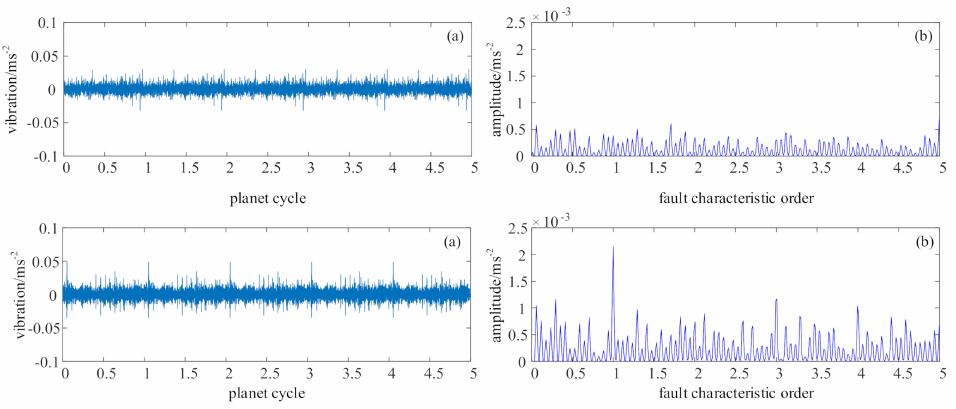
Figure 21. CVS-MED signal: ( a ) health condition waveform, ( b ) health condition envelope order spectrum, ( c ) fault condition waveform, and ( d ) fault condition envelope order spectrum.